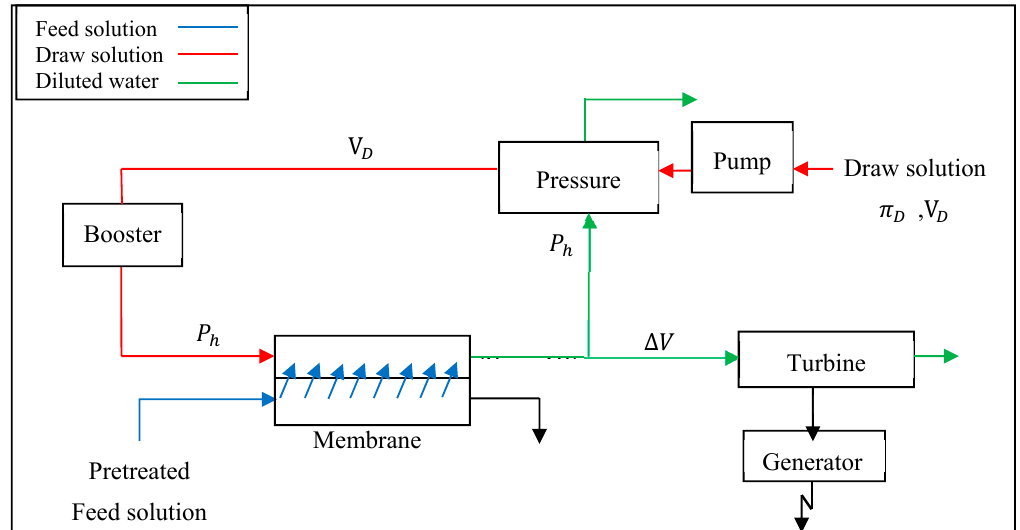
Figure 3. Schematic diagram of power production from PRO power plant.